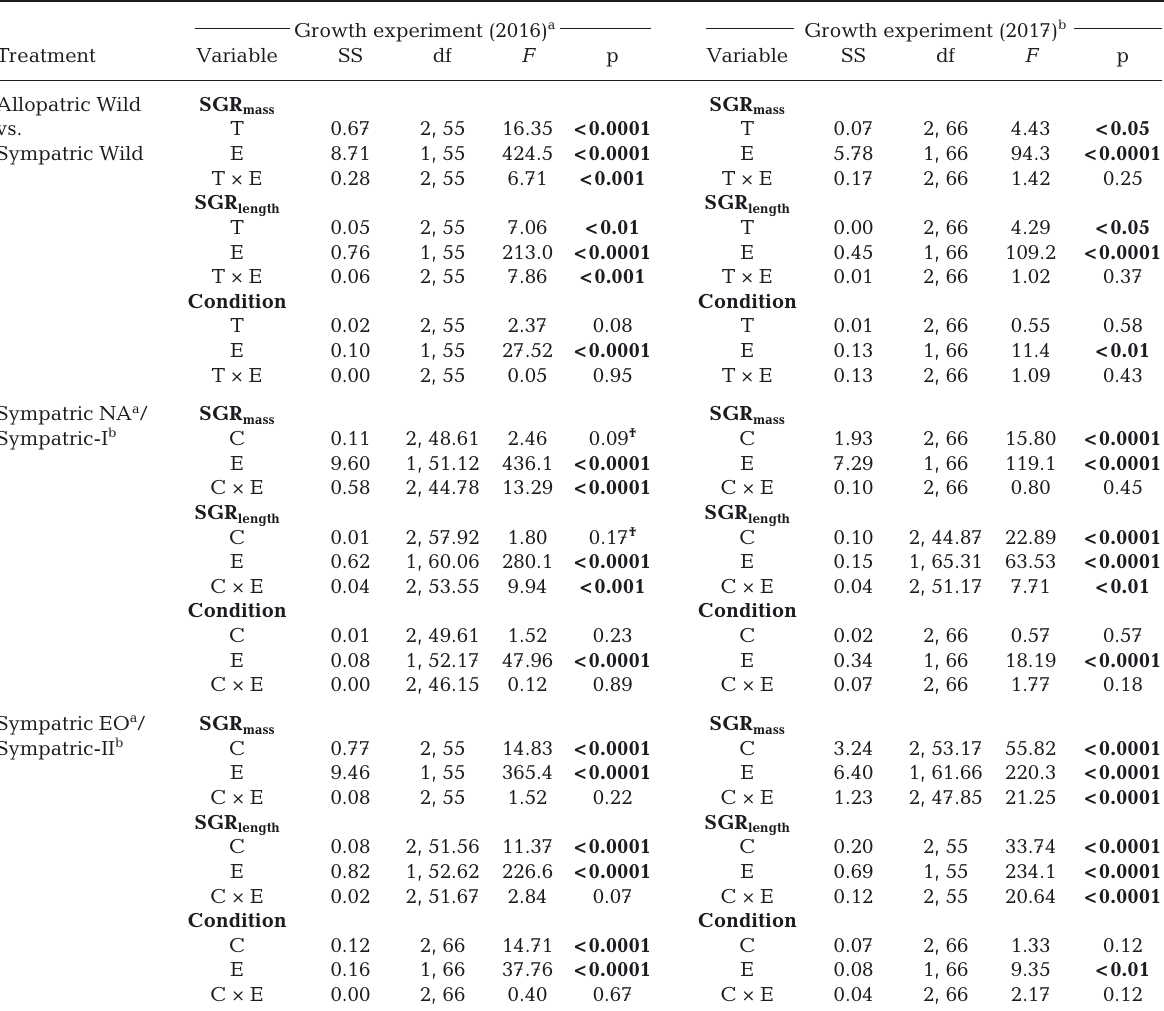
Table 2. Linear mixed-effects model selection for examining growth variation (specific growth rate in terms of mass and length [SGR mass , SGR length ], and condition) in Atlantic salmon between treatments, environments, and cross types from the 2016 and 2017 growth experiments (superscript a and b, respectively). Significant fixed effects (p-values in bold ) were retained in the fi- nal model. † Insignificant fixed effects were also retained in the final model as the interaction terms were significant. Signifi- cant random effects (final density nested within replicate) were also retained in the final model. df: degrees of freedom based